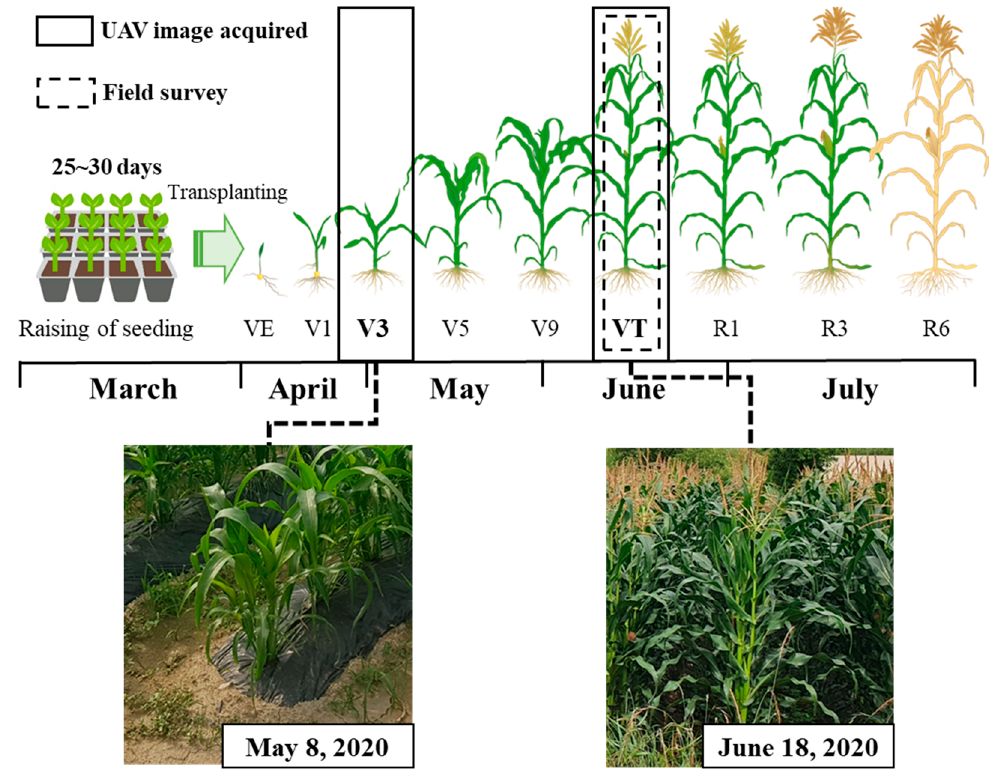
Figure 2. Corn cultivation and growth process: field UAV imaging and field investigation time.